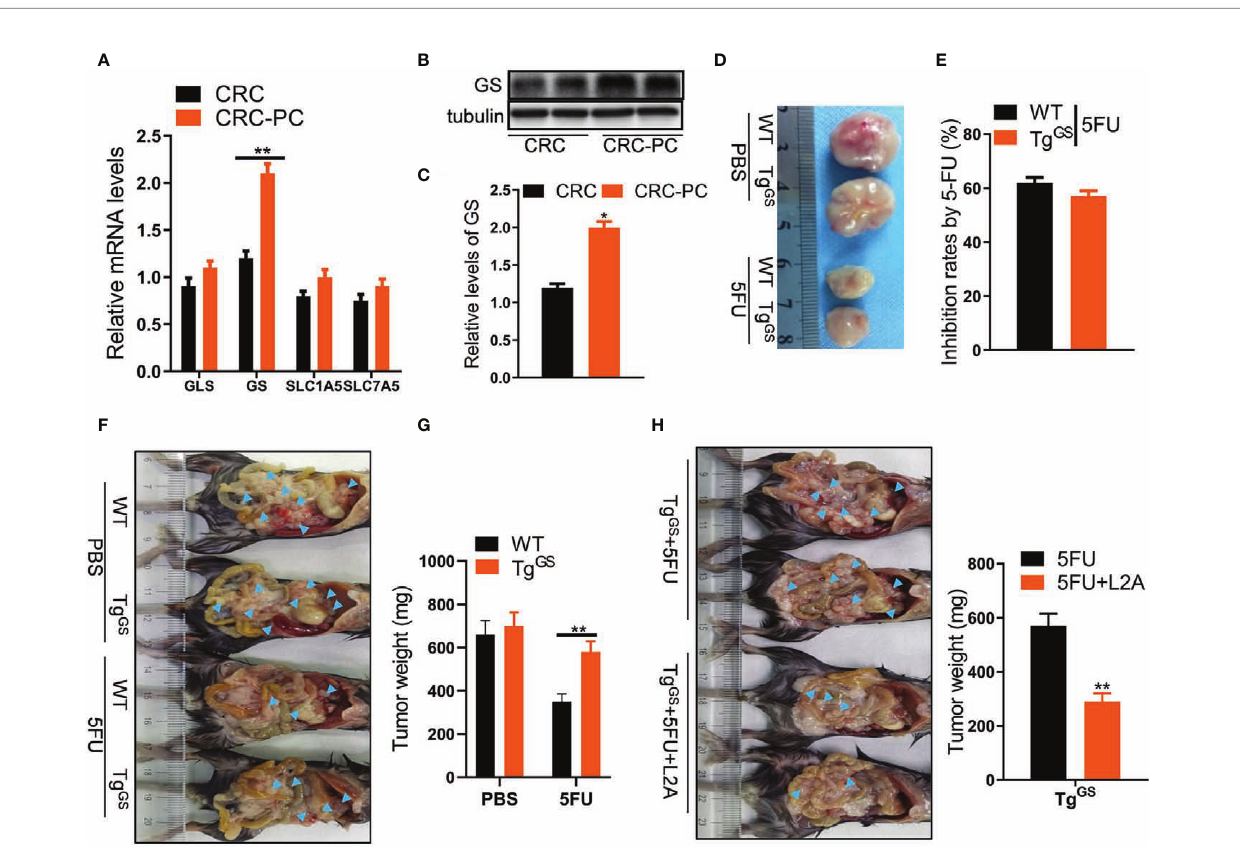
FIGURE 3 | Adipocytic glutamine synthetase (GS) promotes chemoresistance to 5FU therapy in CRC-PC. (A) qPCR detecting relative mRNA levels of GLS, GS, SLC1A5, SLC7A5 in fat tissues from the peritoneum of the CRC model (n = 3) and CRC-PC (n = 3) ** P < 0.01. (B) The protein levels of GS in the CRC-PC model and the CRC model were measured with Western blot. (C) The relative protein levels of GS in (B) were calculated (n = 3, * P < 0.05). (D) The representative images of MC38 tumors (on day 17) from the PBS-treated WT and GS transgenic (Tg GS ) mice, 5FU-treated WT and Tg GS mice. (E) The growth inhibition rates by 5FU in WT and Tg GS mice (n = 5). (F) WT mice and Tg GS mice were intraperitoneally inoculated with MC38 cells, and treated with PBS or 5FU for 2 weeks, respectively. Then, the representative images of the mice-bearing tumors were showed. Arrow heads, tumors. (G) The tumors in (F) were isolated and weighed (n = 3, ** P < 0.01). (H) Left, Tg GS mice were intraperitoneally inoculated with MC38 cells, and treated with 5FU or 5FU+L2A, respectively. Arrow heads, tumors. Right, the tumors were isolated and weighed (n = 3, ** P <